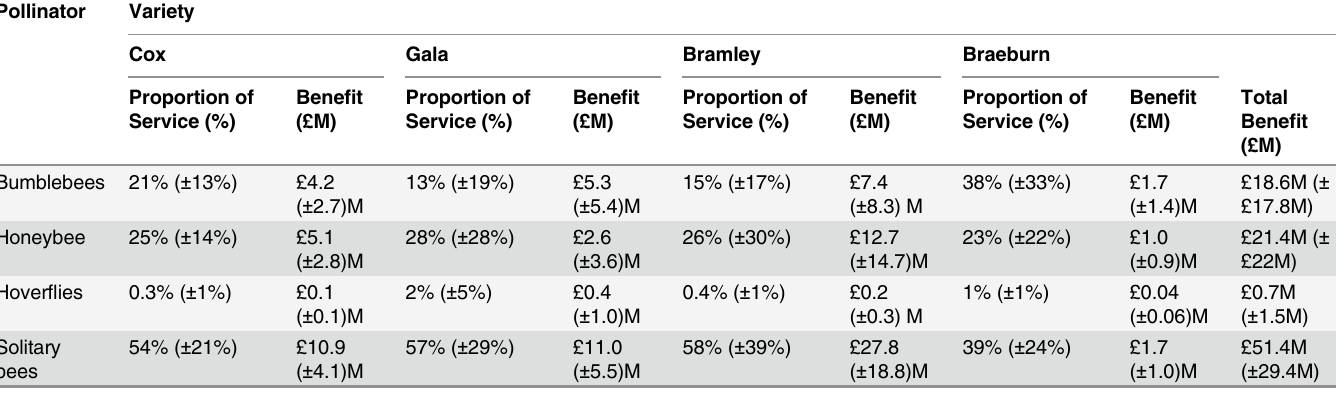
Table 2. Estimated pollination services and economic benefits to each variety provided by the four pollinator guilds studied based on visitation rates and effectiveness (after 3 visits). Measures of standard deviation are included in brackets. Pollinator